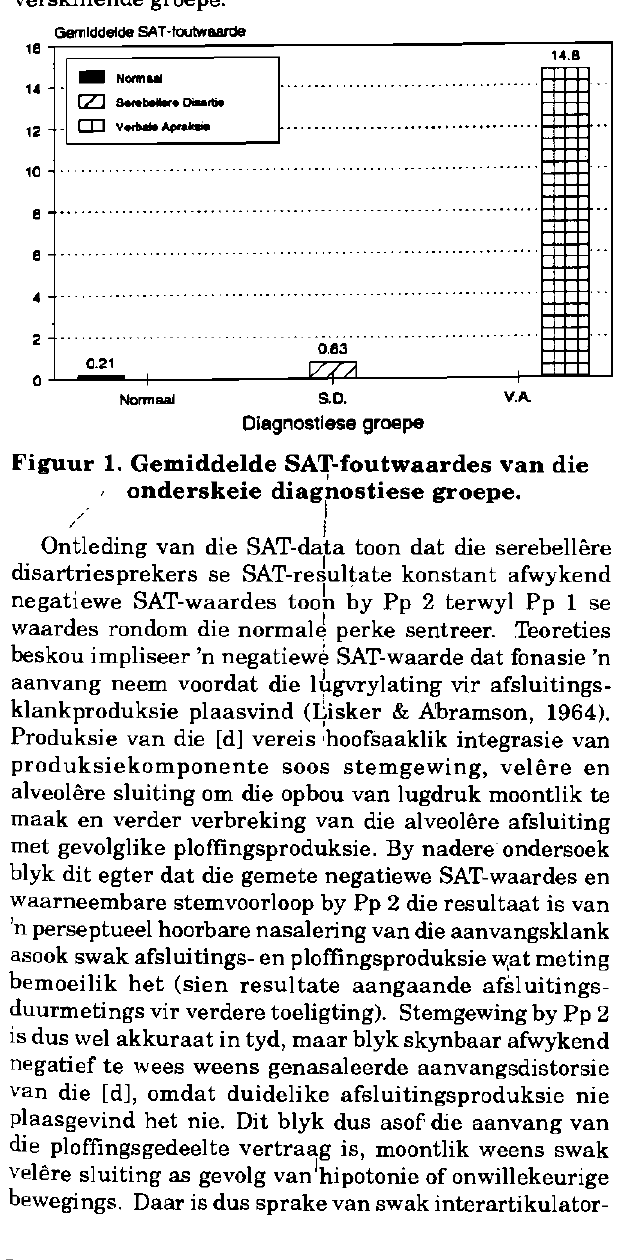
Figuur 2 toon dat die serebellere disartriesprekers se gemiddelde afsluitingsduurwaarde (nl. 0.09 sek) gering korter is as die van die normale sprekers (nl. 0.1